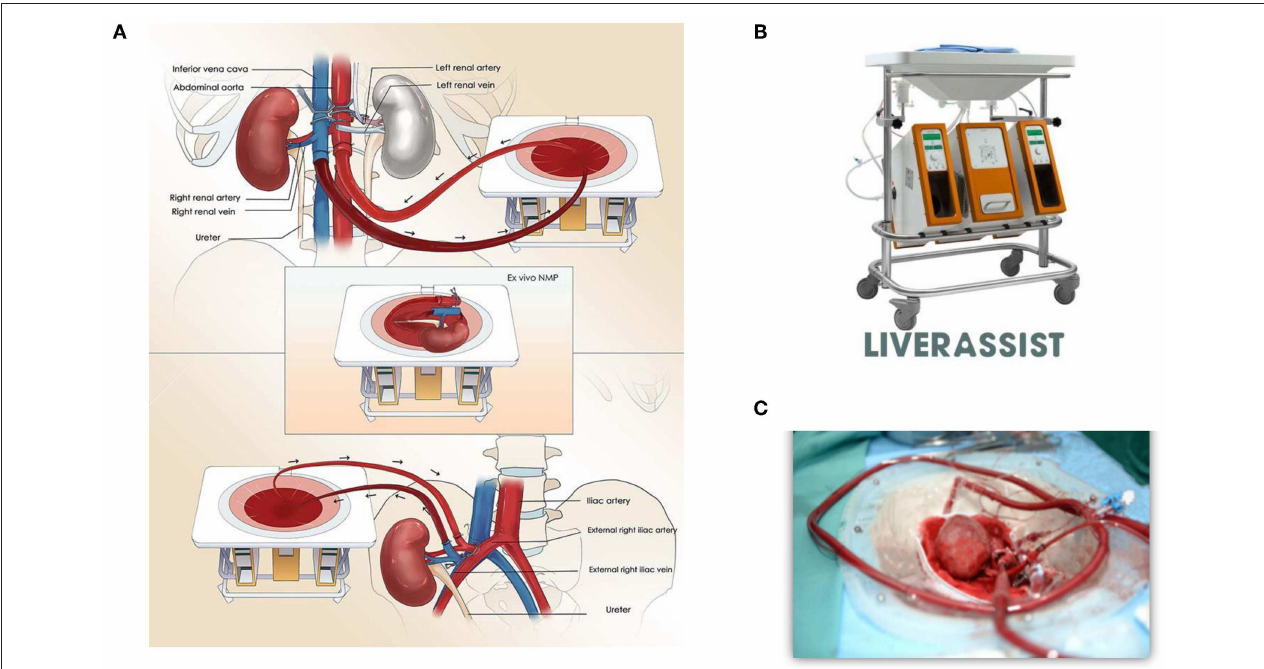
FIGURE 1 | (A) Ischemia-free kidney transplant procedure. The diagram shows procurement, preservation, and implantation of the donor kidney without cessation of blood supply using normothermic machine perfusion. (B) Normothermic machine perfusion device, Liver Assist (Organ Assist, Groningen, the Netherlands). (C) Donor kidney circuit on the organ reservoir of the NMP